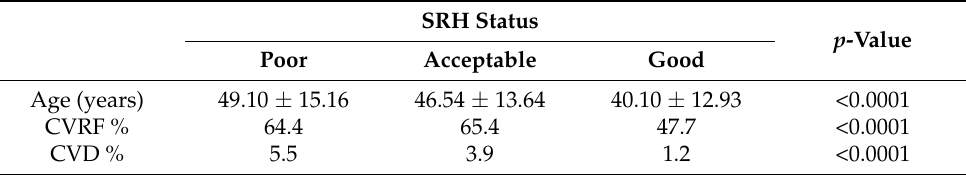
Table 3. Characteristics of the three groups identified on the basis of the by SRH status.